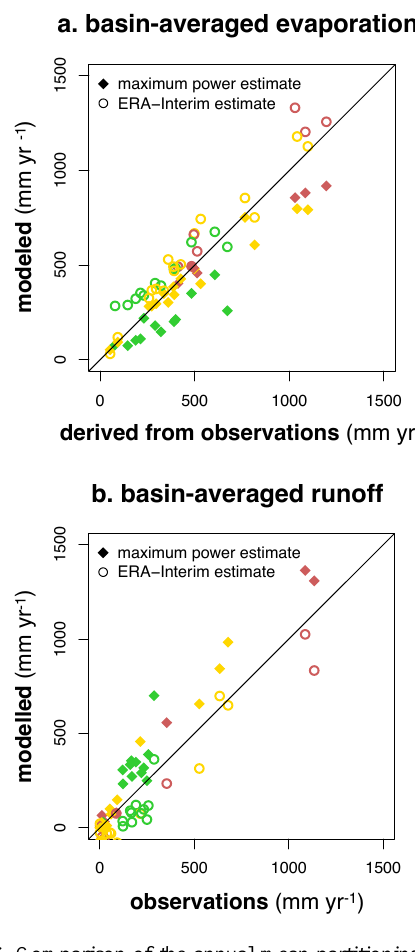
Figure 6. Comparison of the annual mean partitioning of precipi- Fig. 6. Comparison of the annual mean partitioning of precipita- tation, P , into (a) evaporation, E and (b) runoff, Q , of the max- tion, P , into (a.) evaporation, E and (b.) runoff, Q , of the max- imum power estimates and ERA-Interim evaporation to observed imum power estimates and ERA-Interim evaporation to observed estimates inferred from precipitation minus river-basin discharge. estimates inferred from precipitation minus river basin discharge. The color coding marks the geographic location of the basins, as in The color coding marks the geographic location of the basins, as in Fig. Fig. 5.